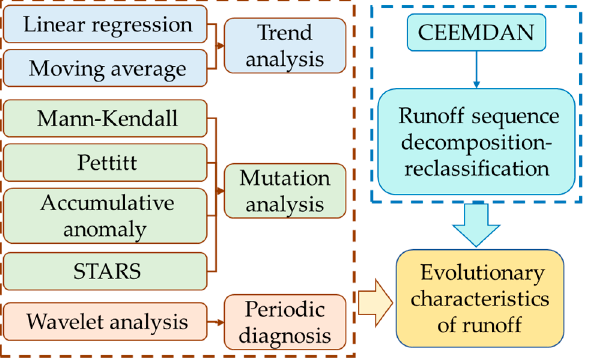
Figure 2. The integrated framework of the methods used to analyze runoff characteristics.